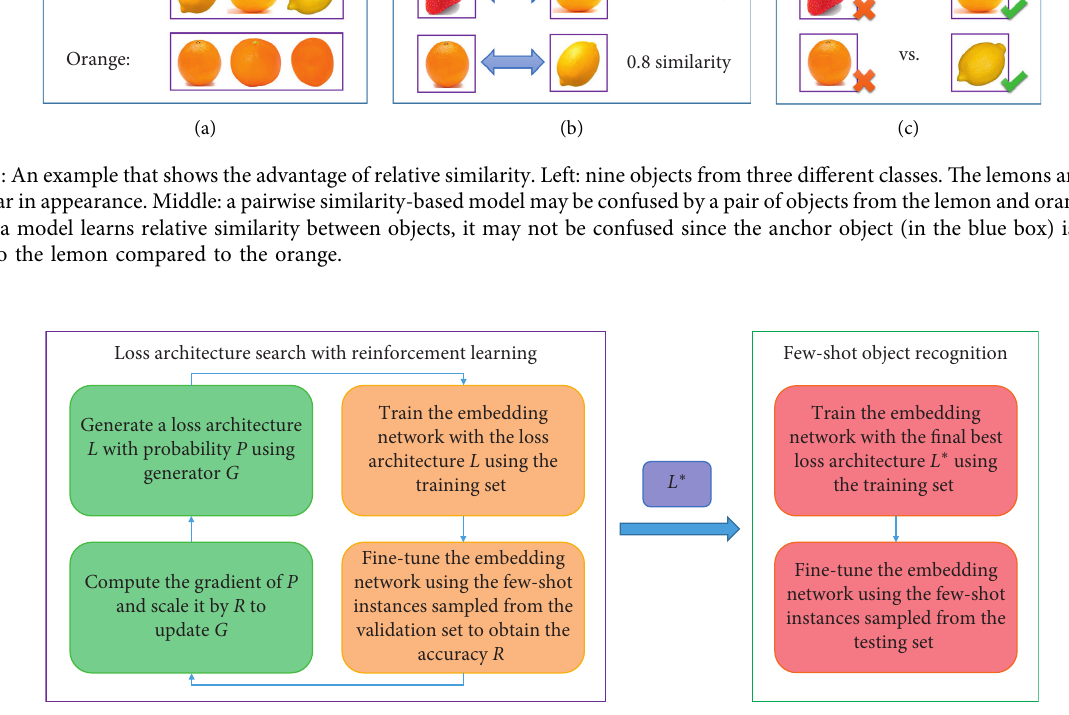
Figure 2: Overview of the proposed loss architecture search (LAS) for few-shot object